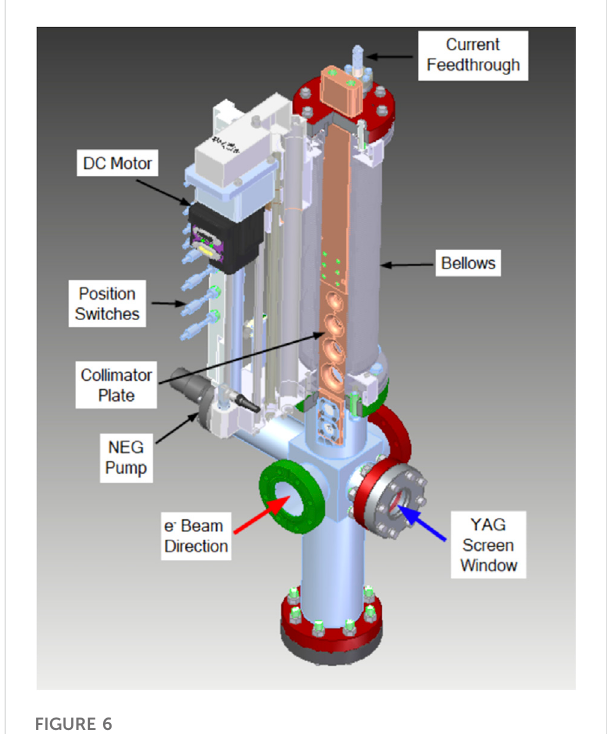
FIGURE 6 Ladder-like multi-function beamline insertion device that includes four circular collimators and two YAG